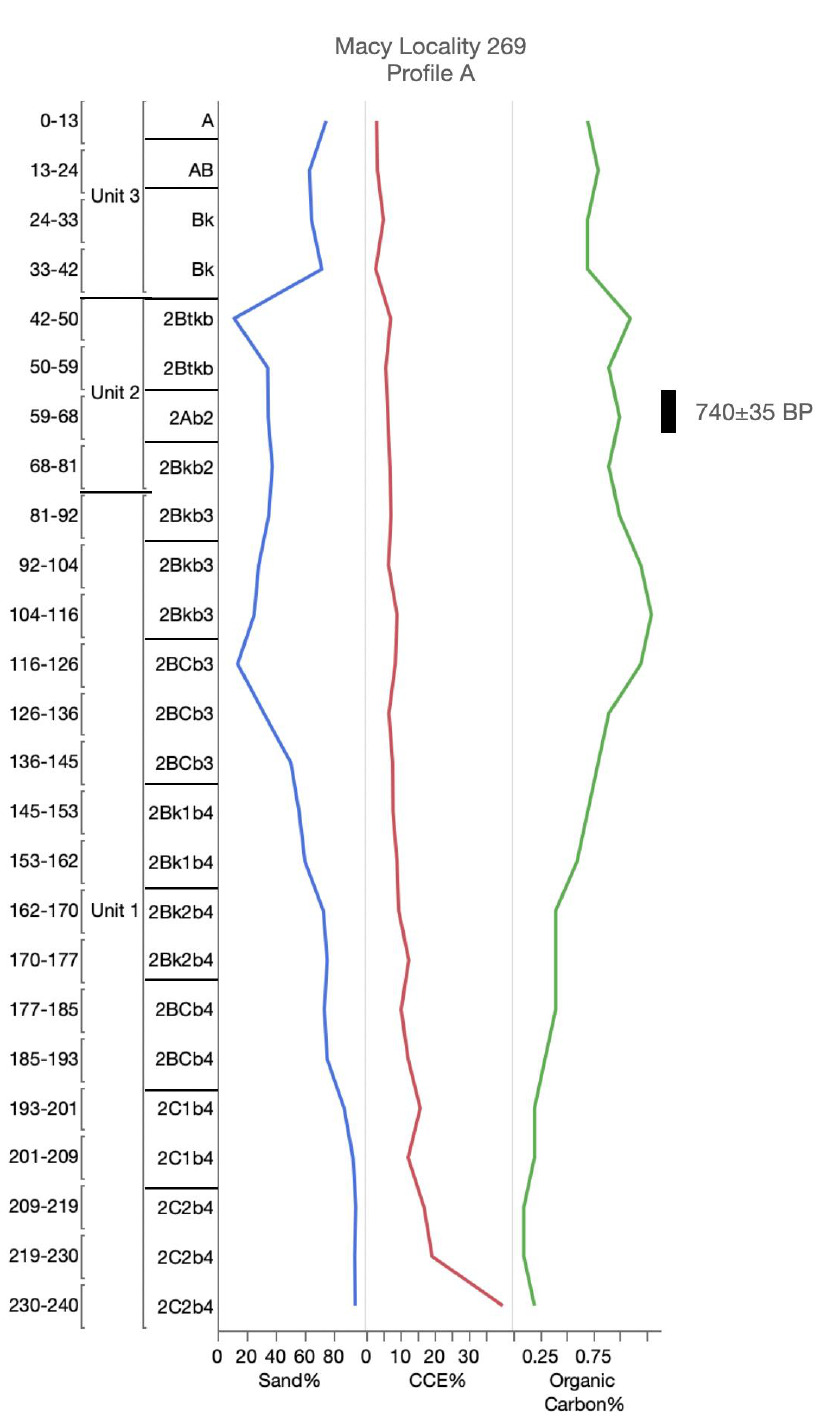
Figure A9. Accepted radiocarbon ages and soil and sediment analysis at Macy Locality 269, Profile A—Post research area, northwest, Texas. CCE = calcium carbonate equivalence.